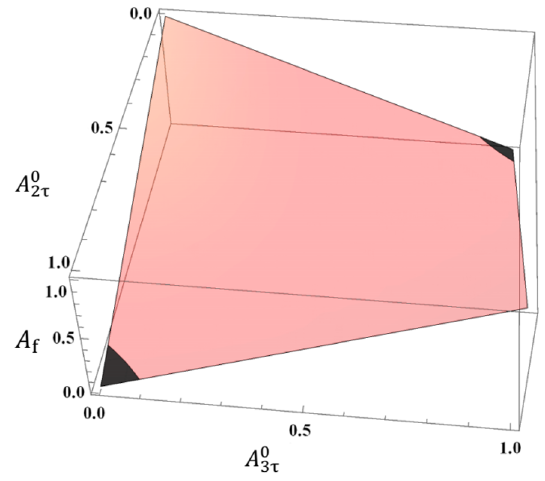
and A 0 . The dark shaded area shows regions 2 τ 3 τ